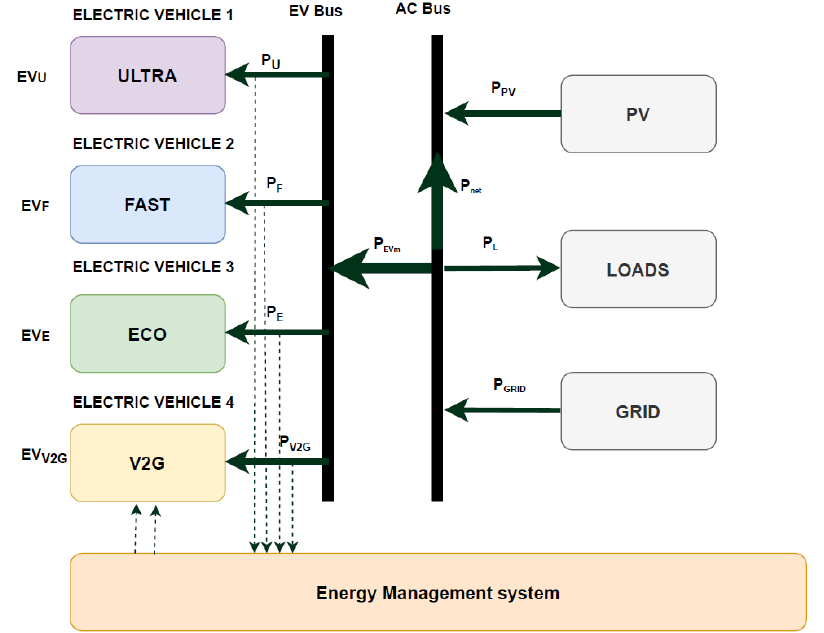
Figure 9. Arrangement of the EMS-based microgrid model .